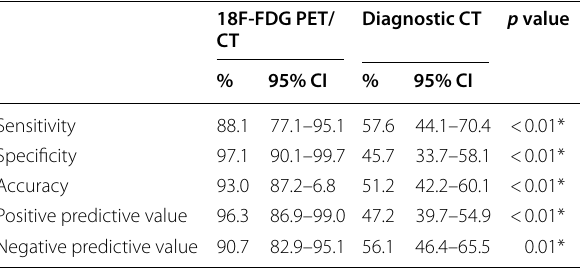
Table 4 Comparison of diagnostic performance between 18F- FDG PET and